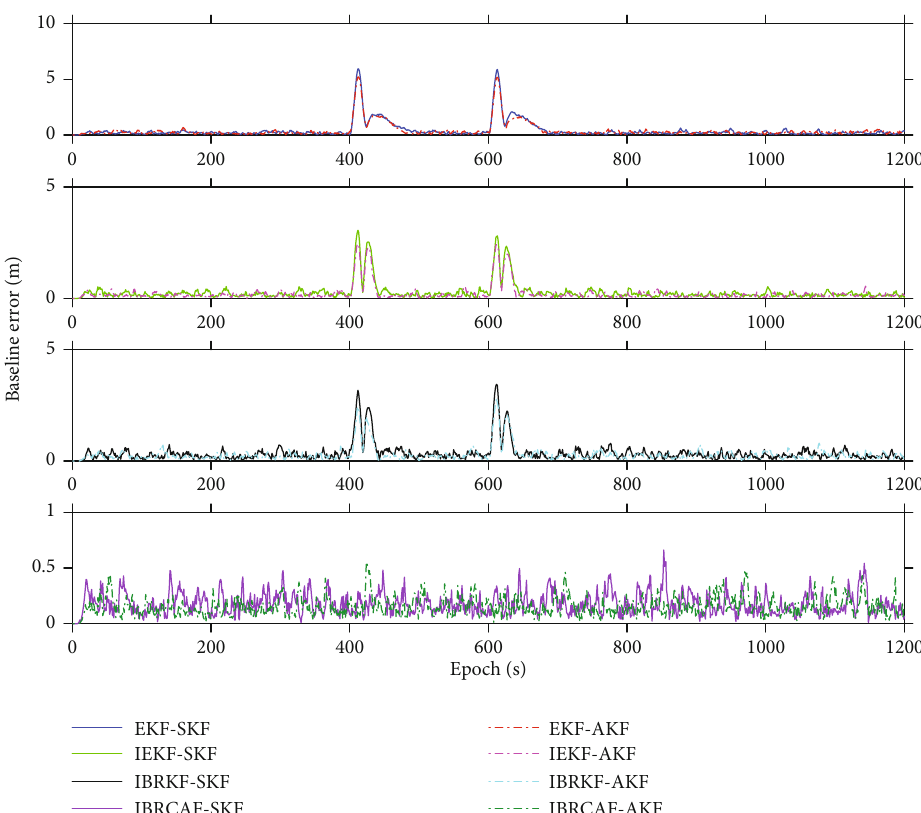
Figure 19: The baseline errors of various algorithms (Data Figure 4. The Ratio threshold is valued 3 in the suc- (1) Set the gyro error with a constant bias 1 ° /h. The cor- correlation time constant of random process for